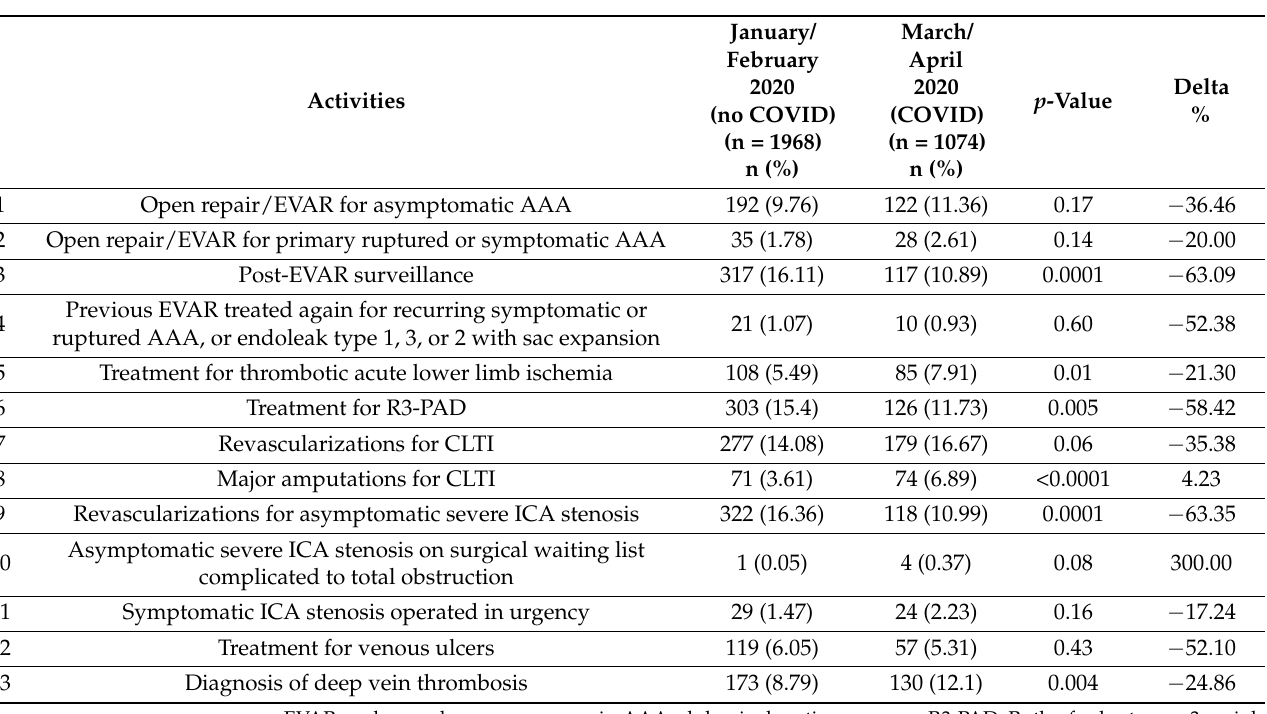
Table 8. Summary of the responses to the questionnaire for the COVID-19 months of